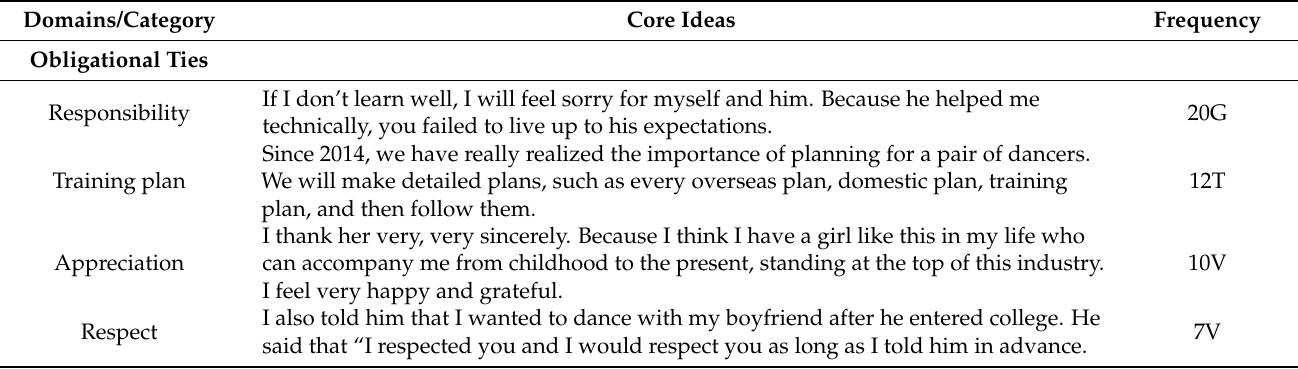
Table 5. Domains and